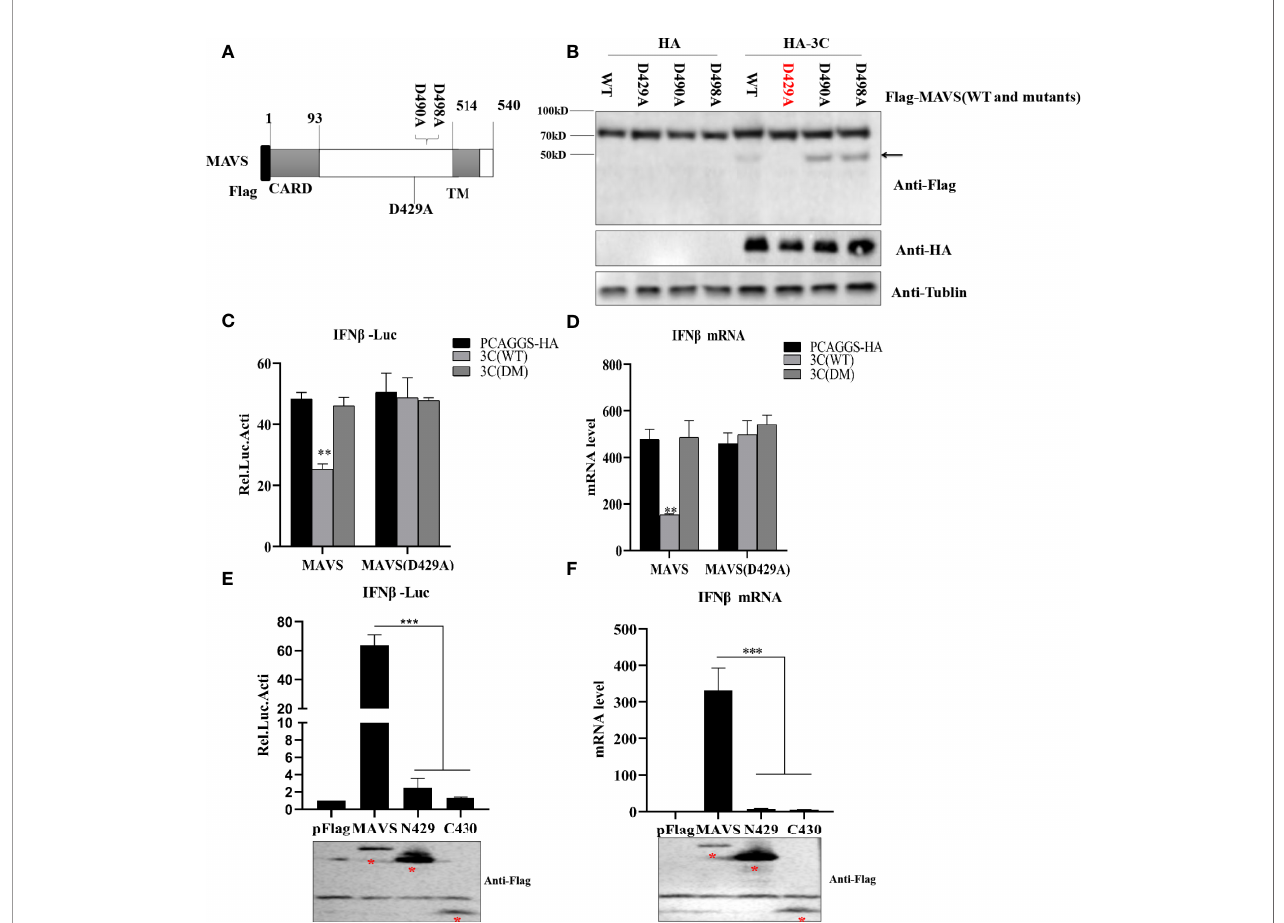
FIGURE 7 | PSV 3C pro cleaves MAVS at D429. (A) Schematic diagram of MAVS and its mutants. (B) HEK293T cells were co-transfected with 500 ng HA-3C and Flag-MAVS or its mutants for 24 h. Cell lysates were analyzed by Western blotting. (C, D) HEK293T cells were transfected with 300 ng MAVS or MAVS (D429A) and HA-3C (WT) or HA-3C (DM). Luciferase activity assay assessed IFN- b promoter activity and qPCR tested the mRNA expression level of IFN b . (E, F) The effects of cleavage fragments of MAVS by PSV 3C pro on MAVS-mediated IFN- b production were assessed via luciferase activity assay and qPCR assay. The expression of MAVS and its mutants was detected by Western blotting using the FLAG antibody. Data are represented as means ± SD. Student ’ s t-test: *P < 0.05, **P < 0.01, ***P <